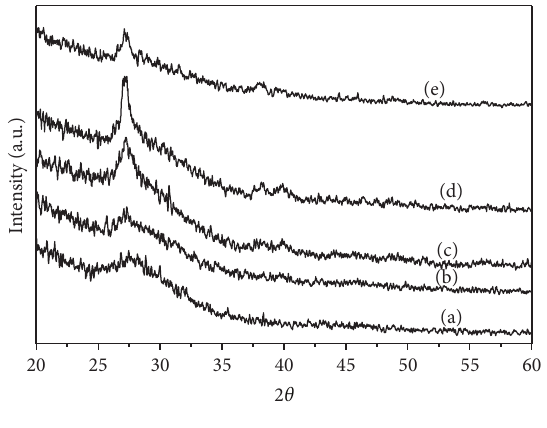
ion-irradiated 3+ 5 ×